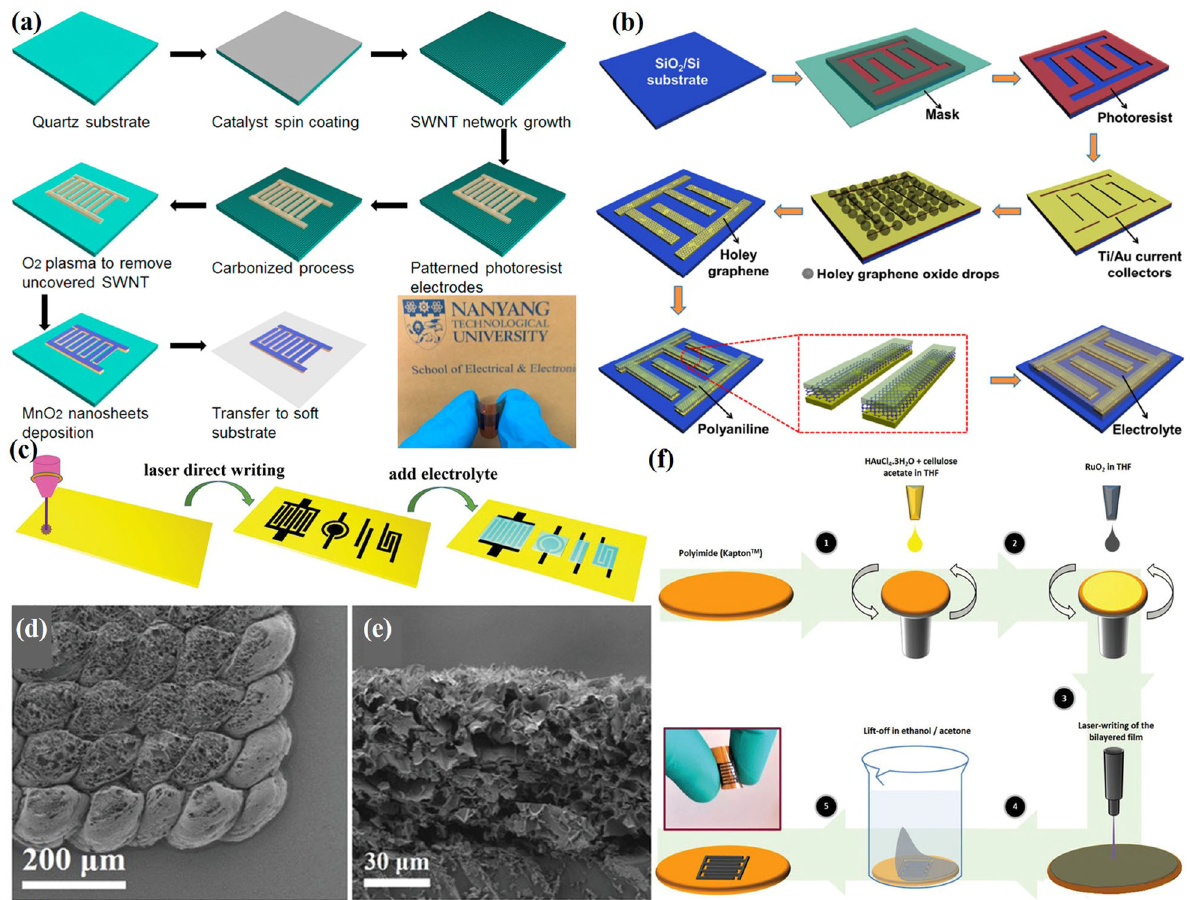
Fig. 3 Photolithography and laser scribing for fabricating MSCs. Schematic illustration of fabrication process for a SWNT/carbon/MnO 2 - based MSC on a soft substrate; b MSCs with holey graphene/polyaniline heterostructures. c Fabrication of LIG fi lms for MSCs by laser scribing. d Top-view and e cross-section SEM images of LIG fi lms. f Fabrication process of RuO 2 -based fl exible MSCs. a Reproduced with permission 57 (Copyright © 2016, Elsevier). b Reproduced with permission 59 (Copyright © 2016, Springer Nature). c – e Reproduced with permission